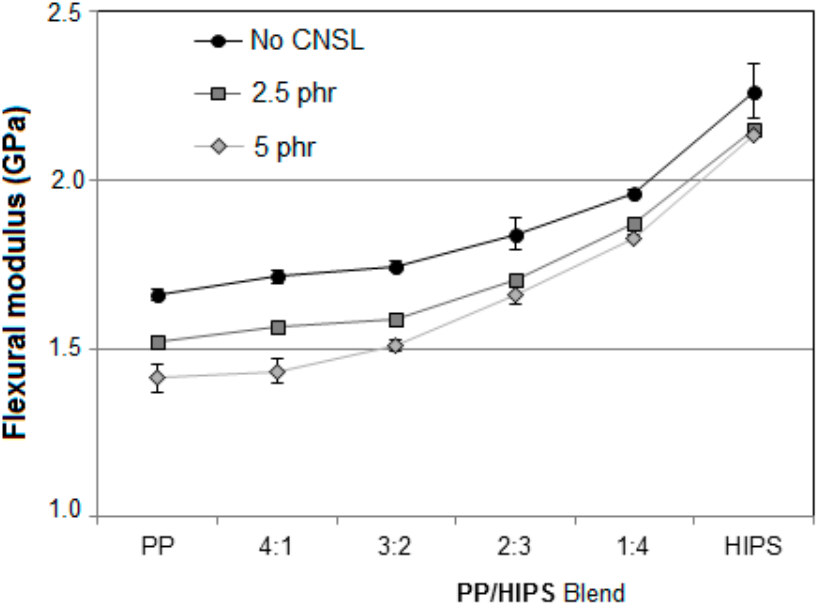
Figure 18. Flexural modulus for neat PP, HIPS and the PP / HIPS blends with 0, 2.5 and 5 phr of CNSL. From these curves it is observed that increasing flexural modulus is directly related to the